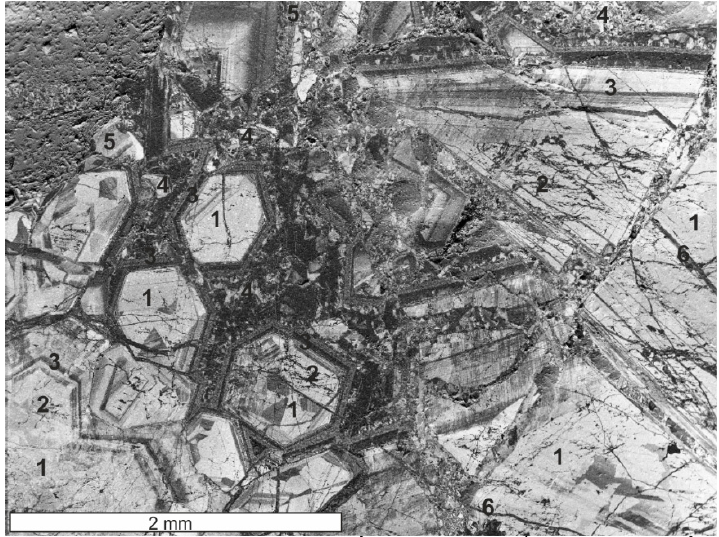
Figure 5. Typical SEM-CL texture with the identified steps of the quartz formation process (Boccassuolo). 1. Core of early quartz (Qtz 1) formed at the highest temperature. 2. Quartz growth was interrupted by microfracturing. 3. Early quartz (Qtz 1) precipitation continued with euhedral growth zones. 4. Medium (Qtz 2) to fine grained (Qtz 3) interstitial quartz and calcite precipitated from continuously cooling hydrothermal fluid. 5. Low temperature fine grained quartz (Qtz 3) may cause microbrecciation. 6. A few generations of microfractures are filled with low temperature